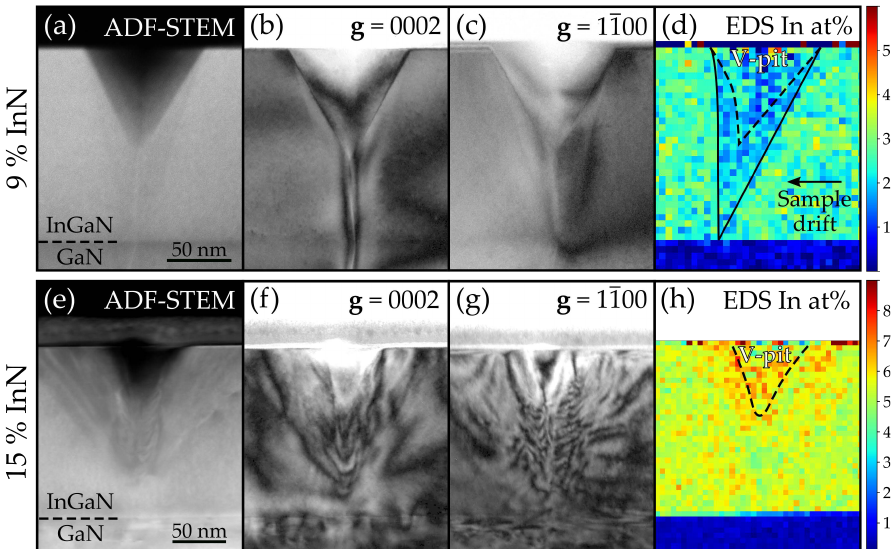
Figure 5. TEM results for a V-pit cross section in the In 0.09 Ga 0.91 N sample showing ( a ) ADF-STEM ( b ) bright field image taken with g = 0002 ( c ) bright field image taken with g = 1¯100 and ( d ) STEM-EDS indium concentration map - the V-pit edges are indicated by a dashed line, and the solid line marks the boundary of a low indium region. ( e – h ) show similar results for a V-pit cross section in the In 0.15 Ga 0.85 N sample. All images taken looking down the (cid:104) 11¯20 (cid:105) zone